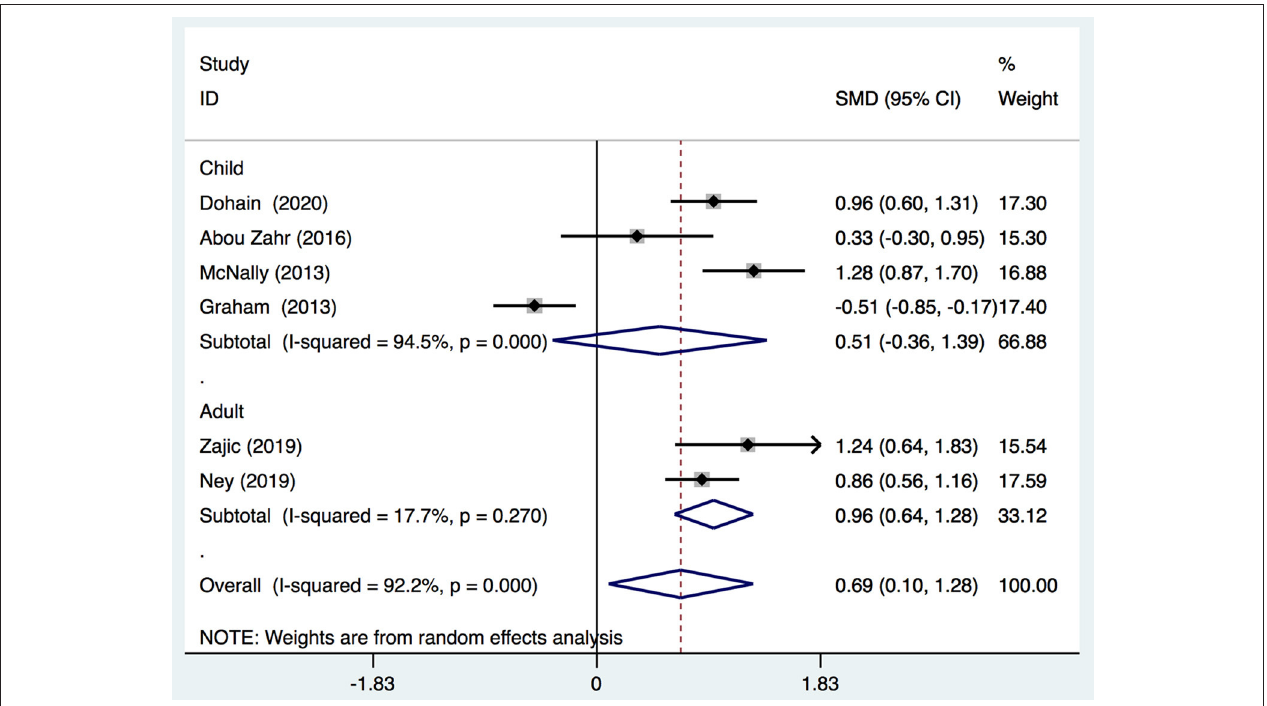
FIGURE 2 | Forest plot for comparison of the VitD level pre-operation and immediately post-operation identified in the meta-analysis of six trials using random-effect model. Only the first author of each study is given. Test for overall effect, z = 2.28, P = 0.02; test for heterogeneity, I 2 = 92.2%, P = 0.000. SMD, standard mean difference. CI, confidence